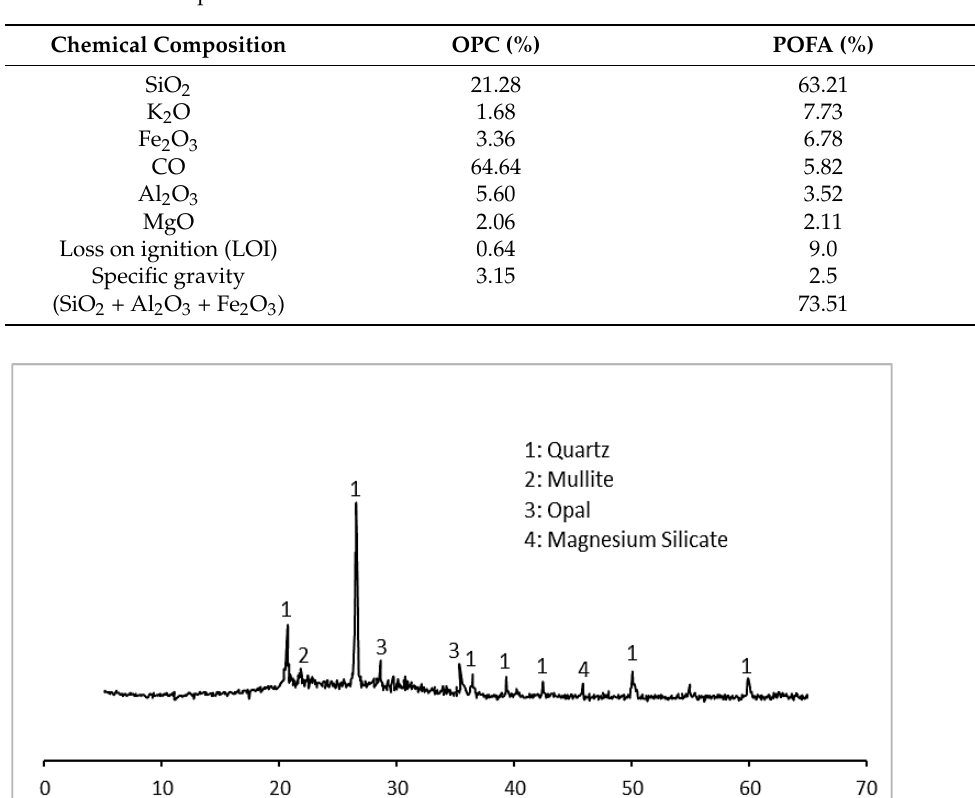
Figure 1. XRD diffractogram of POFA.